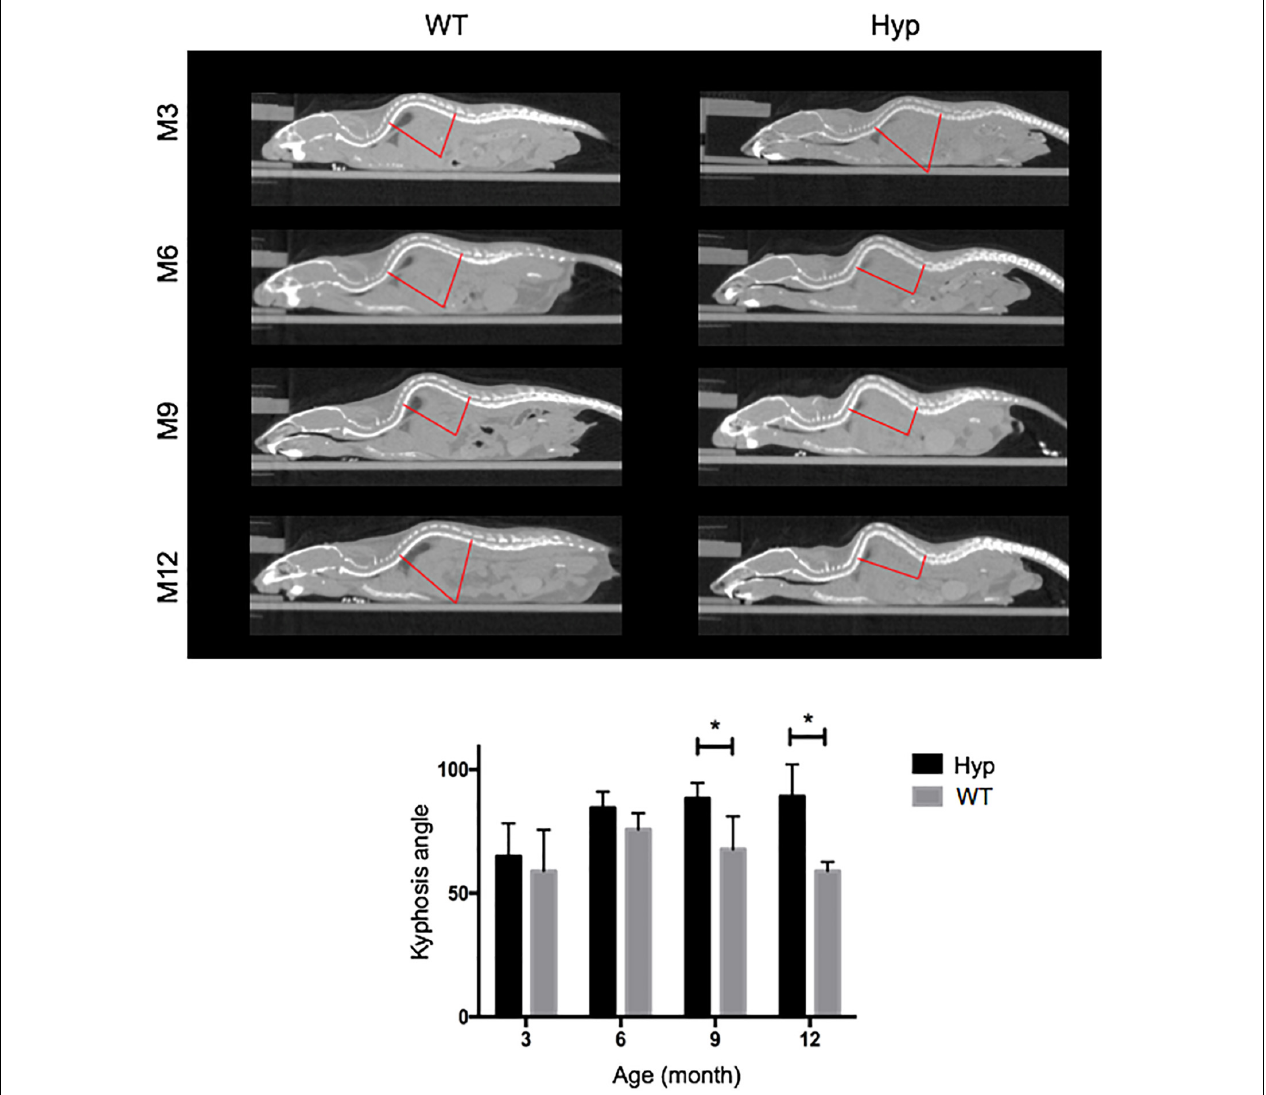
FIGURE 4 | Angle of dorsolumbar kyphosis of mice at M3, 6, 9, and 12. The kyphosis angle was significantly larger from M9 in Hyp mice than WT mice (* p < 0.05) (representative micro-CT sections from Hyp# 2 mouse).